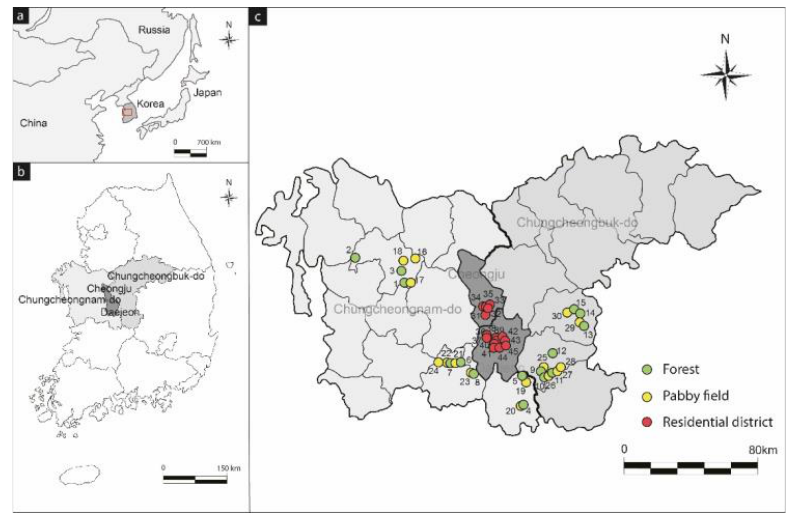
Figure 1. Locations and study area ( a , b ) and sampling points ( c ).